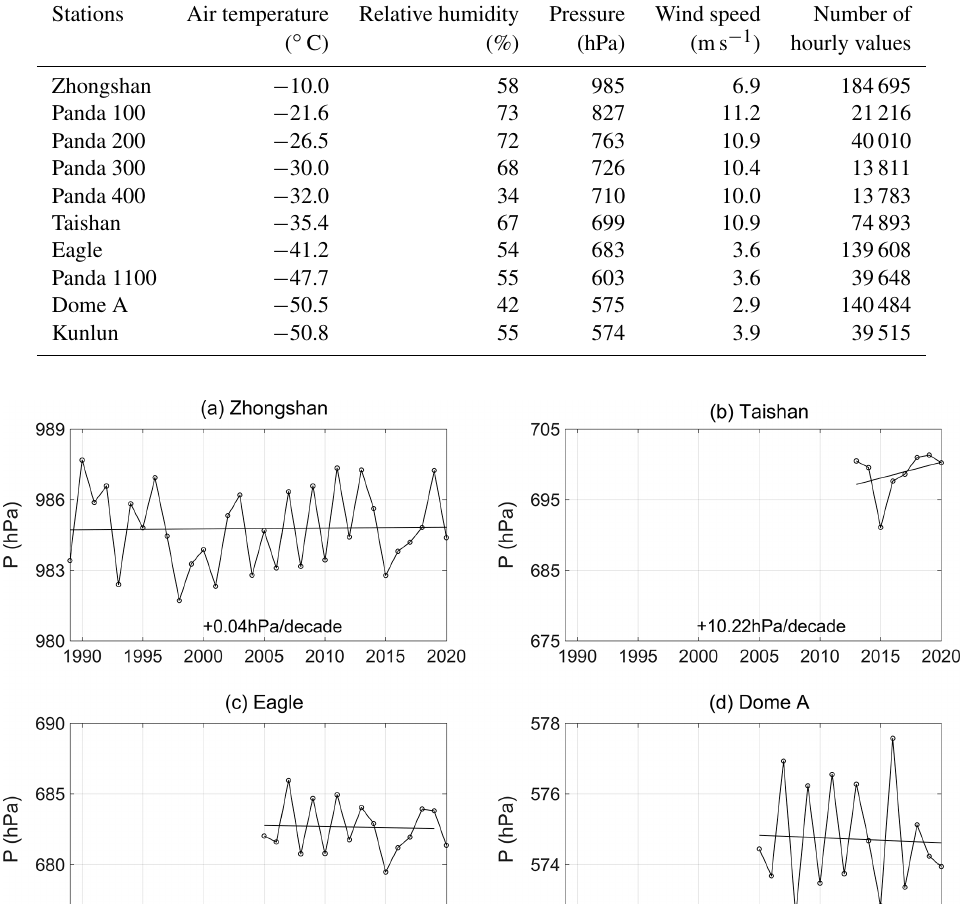
Table 2. The mean values of meteorological variables at AWSs in the PANDA network.